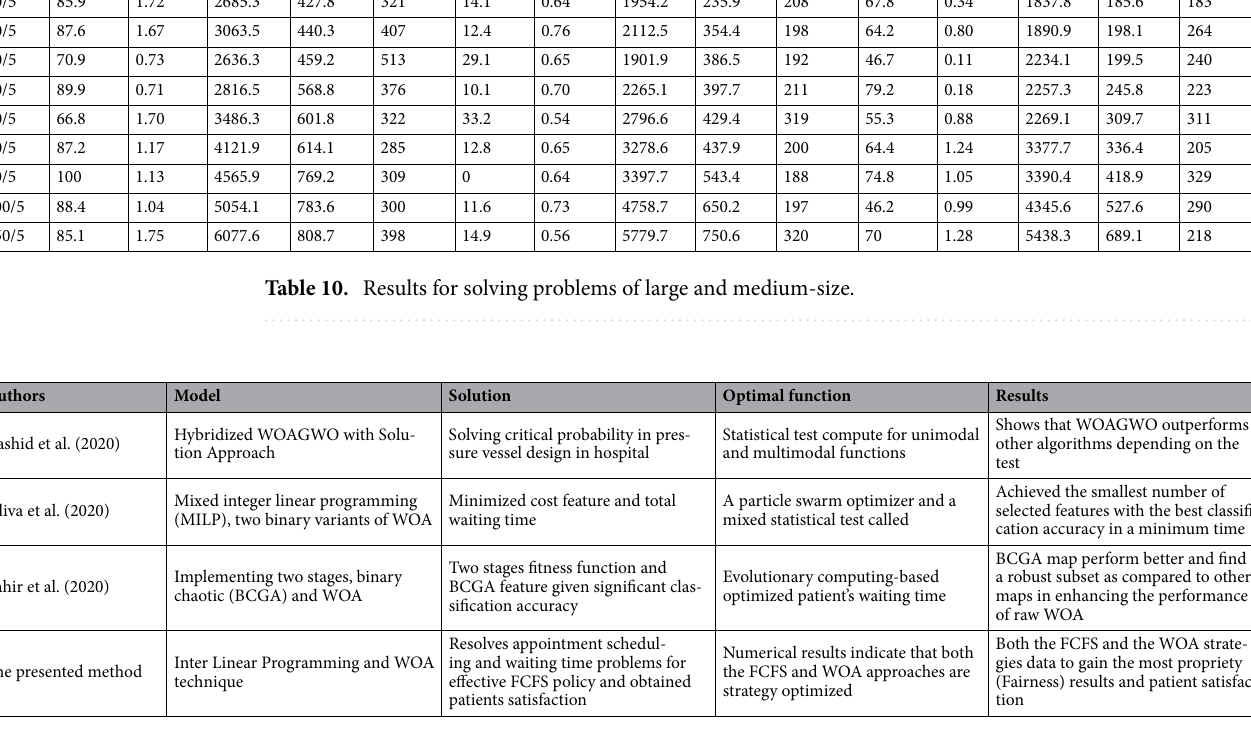
Table 11. The comparison between the